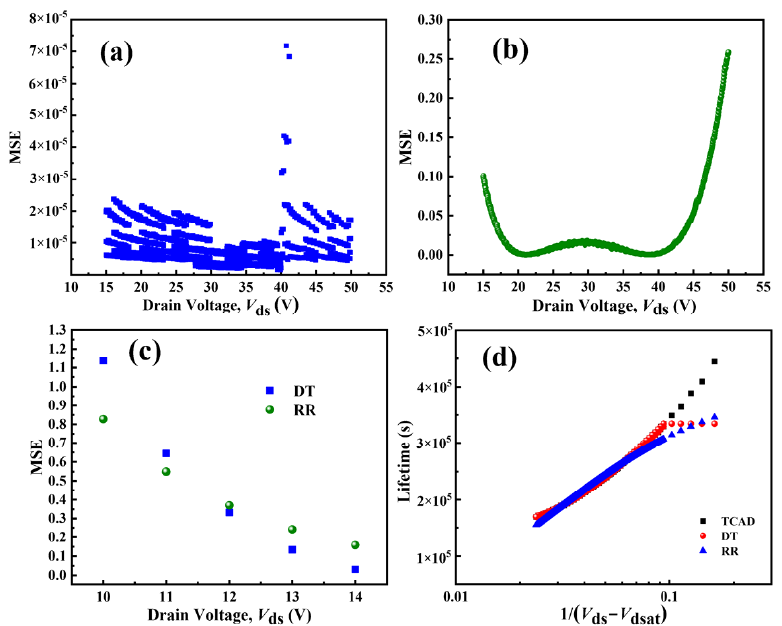
Figure 13. Comparison of the training data with the predicted results of ( a ) DT and ( b ) RR. ( c ) The extrapolation MSE of the DT and RR algorithms. ( d ) Comparison of two algorithms in lifetime prediction.